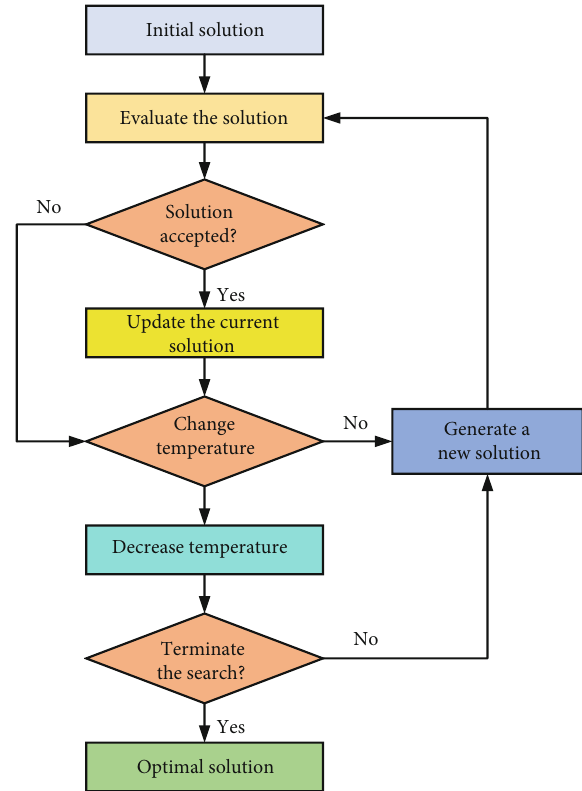
Figure 14: Flowchart for optimization using the SA algorithm based on Zain et al.